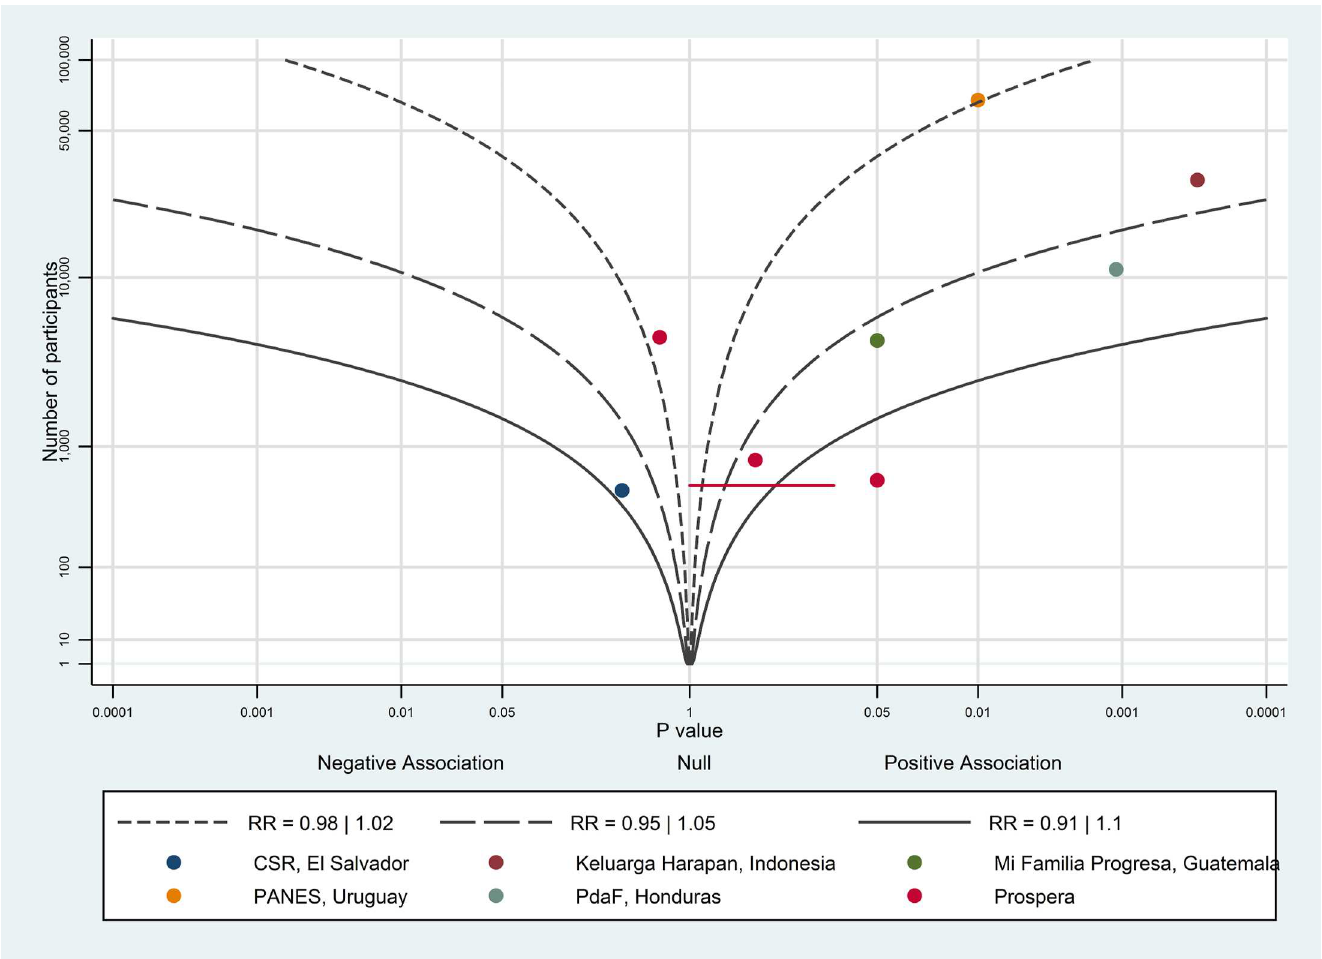
Fig 2. Albatross plot for effect of conditional cash transfer programmes on uptake of antenatal care. CSR—ComunidadesSolidariasRurales; PANES—Plan de Atencio´n Nacionala la Emergencia Social; PdAF—Programade Asignacio´n